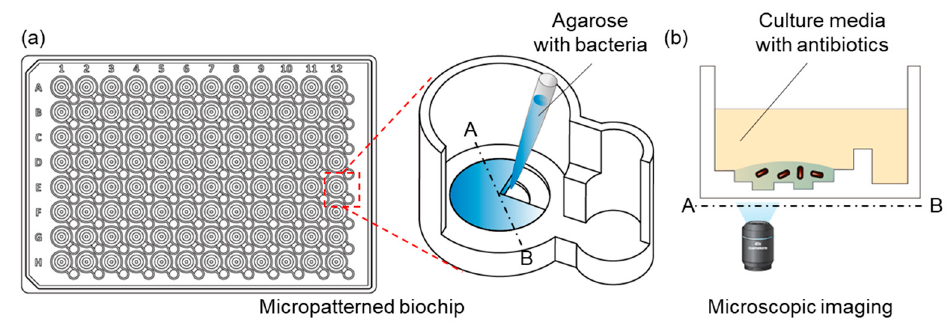
Figure 2. ( a ) Schematics of micropatterned biochip based on 96 ‐ well plate format. Detailed structure of a single well, containing a main well and a side well. The larger main well is inoculated with a mixture of bacteria and agarose. The smaller side well is for antimicrobial agents with MHB medium. ( b ) Schematic of cross ‐ section view of testing well. Antibiotic solutions diluted with MHB are applied to the side well, after which diffusion occurs toward the main well. Bacteria are fixed with agarose and the culture media with antibiotic diffuse into the agarose.